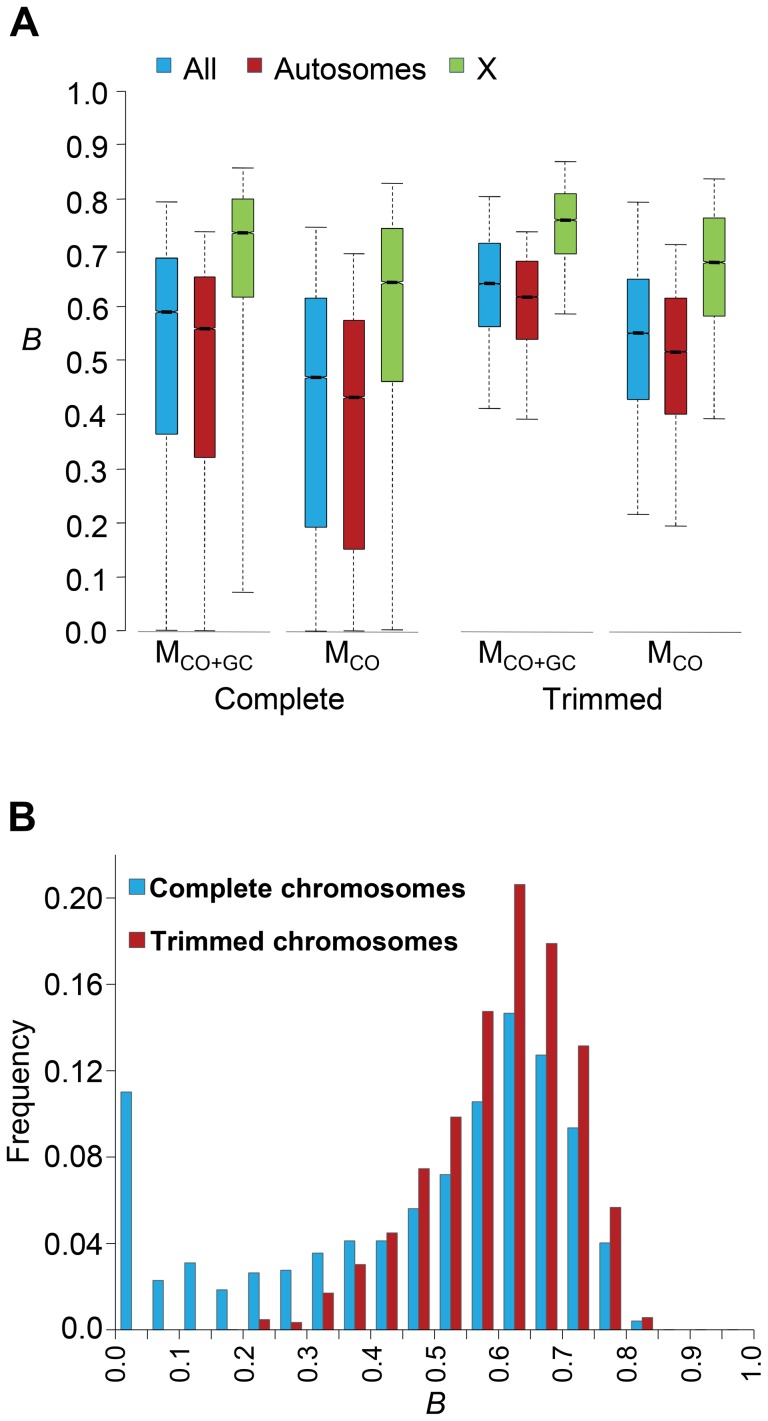
Genome-wide estimates of BGS.(A) Boxplots of estimates of B for complete or trimmed chromosomes and for models MLN,StdMut,CO+GC (MCO+GC) and MLN,StdMut,CO (MCO). Results shown for the complete genome, and autosomes and the X chromosome separately. The median is identified by the line inside the box, the length of the box and whiskers indicate 50% and 90% CI, respectively. (B) Frequency distribution of B estimates for complete or trimmed chromosomes under model MLN,StdMut,CO+GC. All results based on the analysis of 1-kb non-overlapping regions.